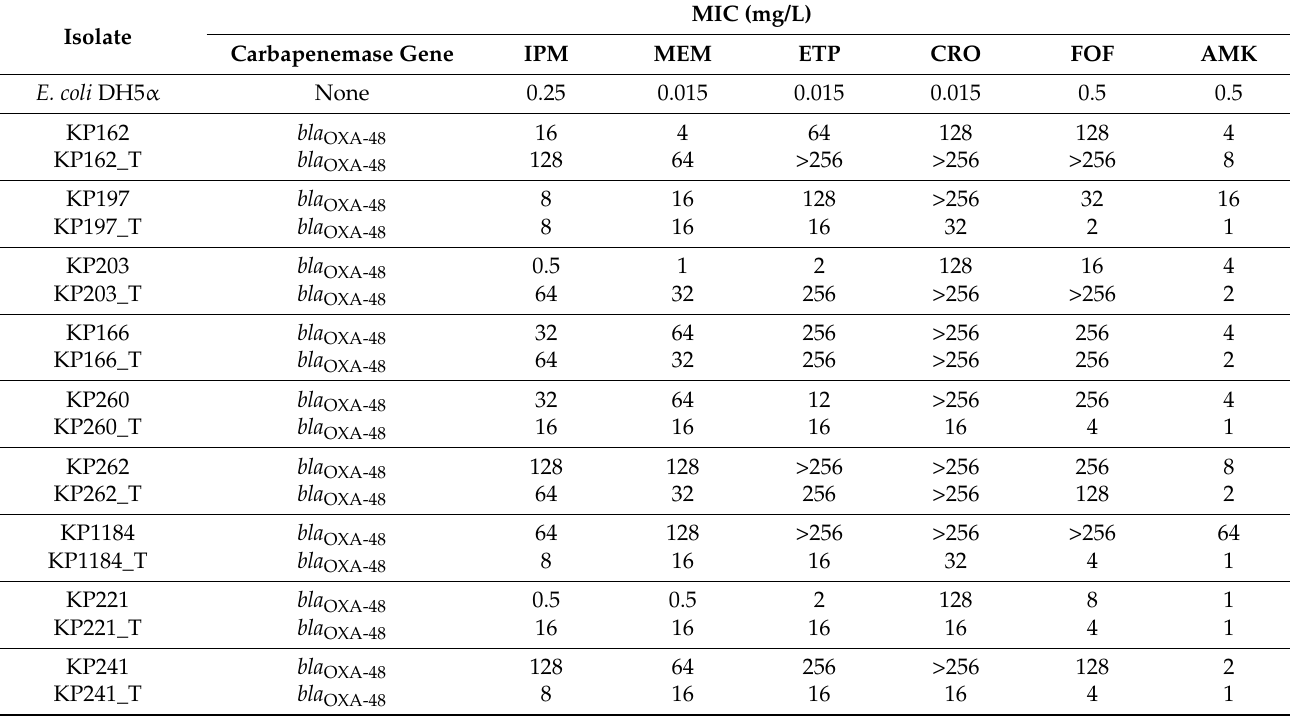
Table 2. Antibiotic susceptibility of nine OXA-48-producing K. pneumoniae isolates and E. coli DH5 α transformants. Isolate